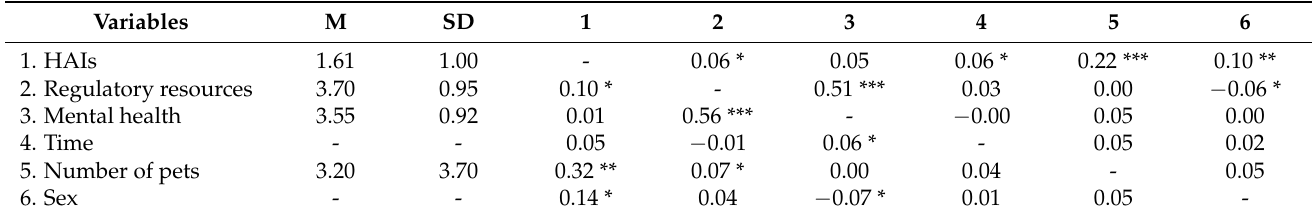
Table 1. Means, standard deviations, and between- and within-person-level